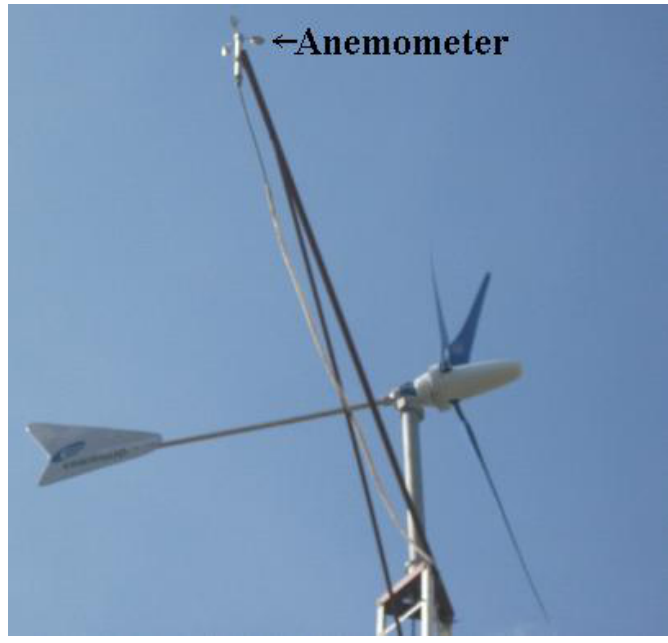
Figure 5. Anemometer at the UFC Campus, Fortaleza, Brazil.